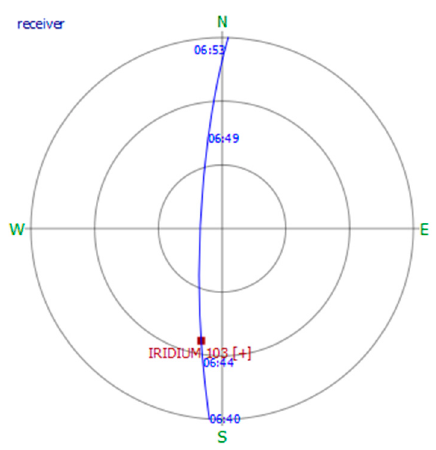
Figure 11. Sky plot of the first visible IRIDIUM NEXT satellite.